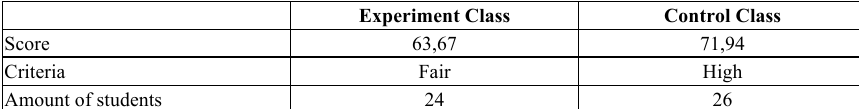
Table 2. Mean score of the pretest of the e-learning classes